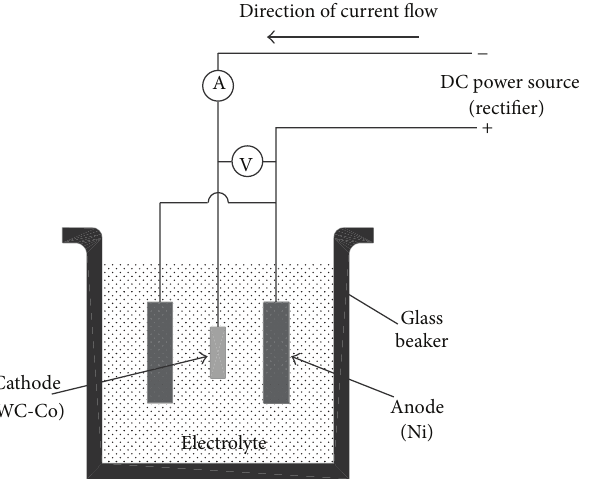
Figure 1: Schematic of the electroplating cell.